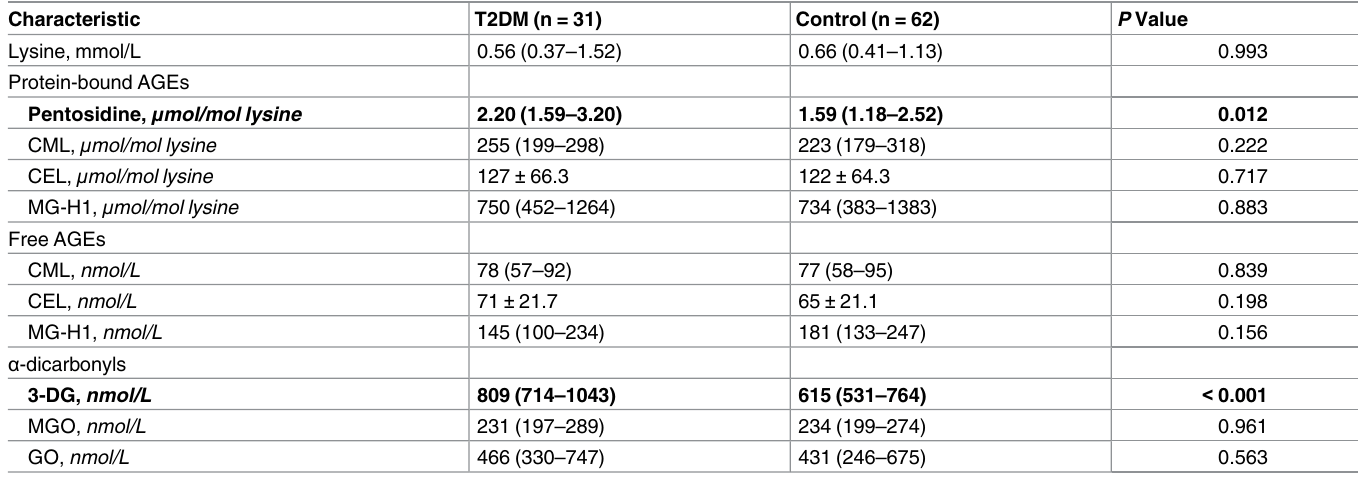
Table 2. Biochemical characteristics of the